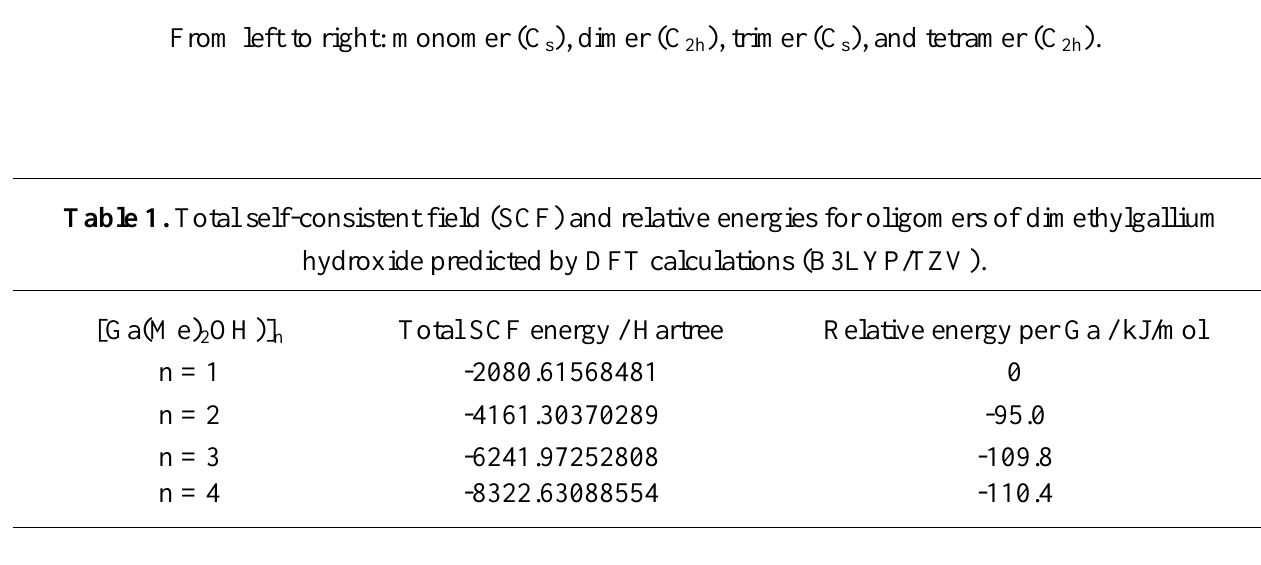
Figure 3 . Illustration of the Me From left to right: monomer (C